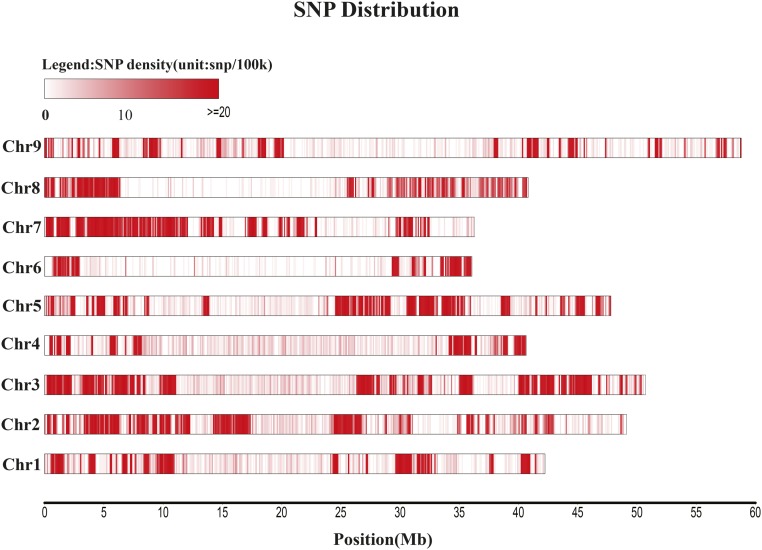
SNP distribution on the nine foxtail millet chromosomes. SNP, single nucleotide polymorphism.